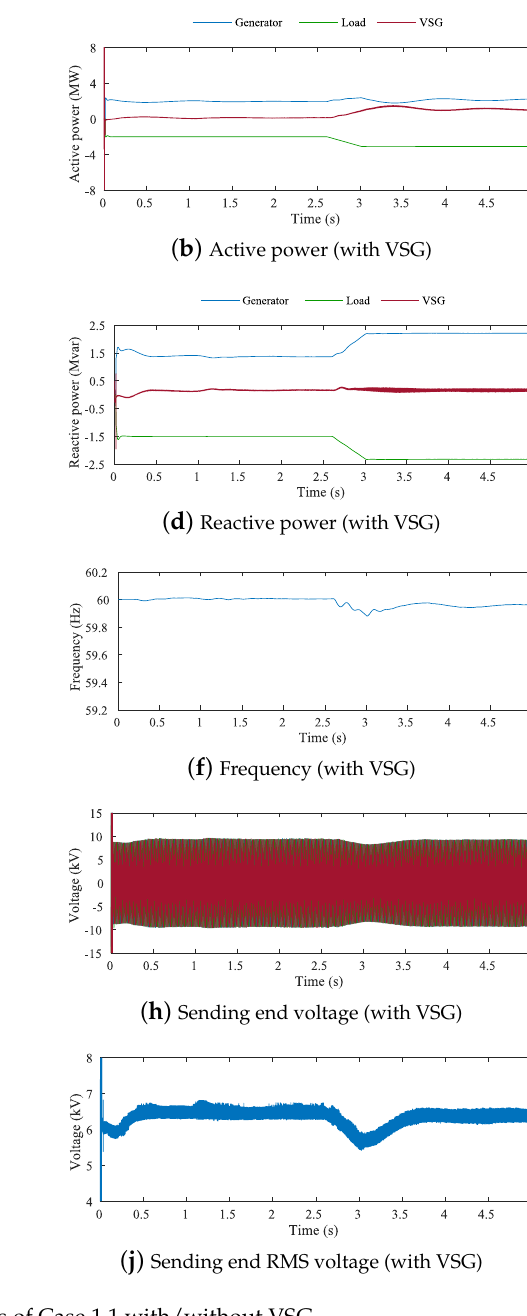
Figure 11. Simulation results of Case 1.1 with/without